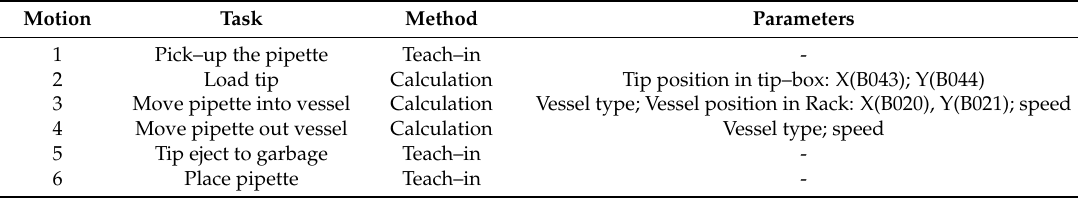
Table 4. Robot motion types and tasks, implementation method, and